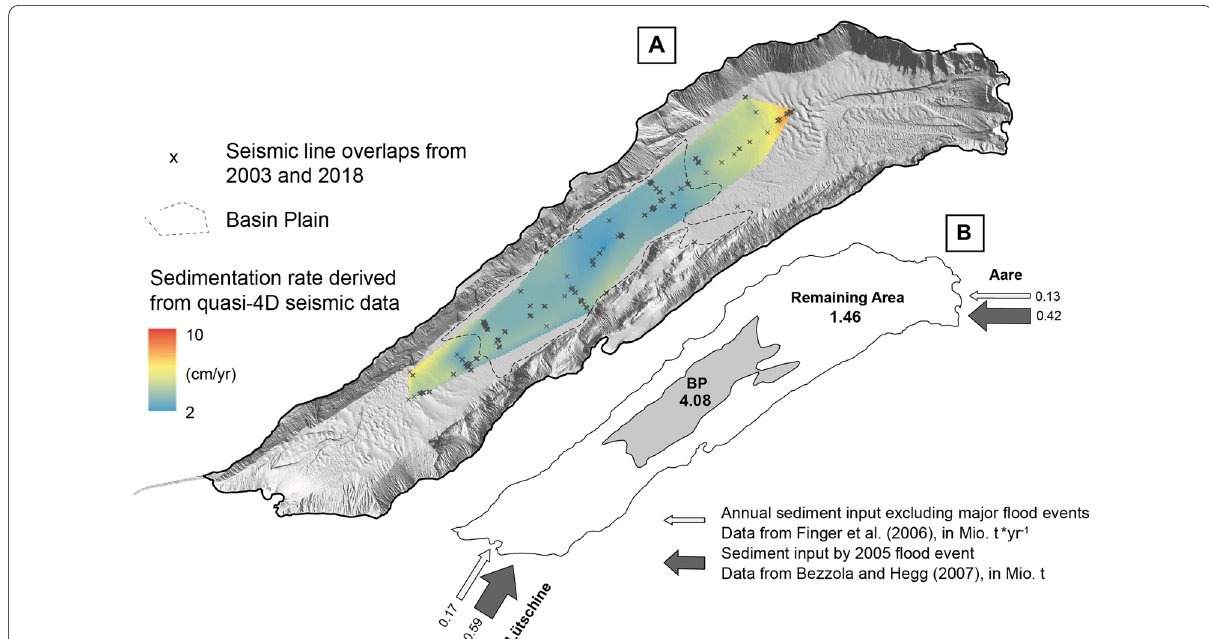
Fig. 6 A Sedimentation rates as interpolated from seismic data from 2003 (Girardclos et al., 2007) and 2018 (this study). Crosses indicate overlapping of the reflection seismic profiles where sedimentation rate could be calculated directly. B The simplified sketch shows the sediment dynamics in Lake Brienz. Numbers represent sediment loads [Mio t] as calculated for the time period 2003–2018. Arrows indicate mean annual sediment input [Mio t/yr] and additional sediment input [Mio t] corresponding to the 2005 flood event of the main tributaries